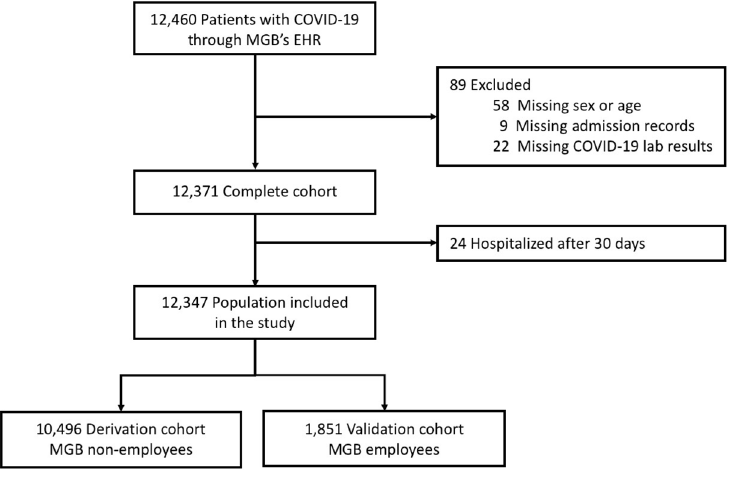
Figure 2. Study population